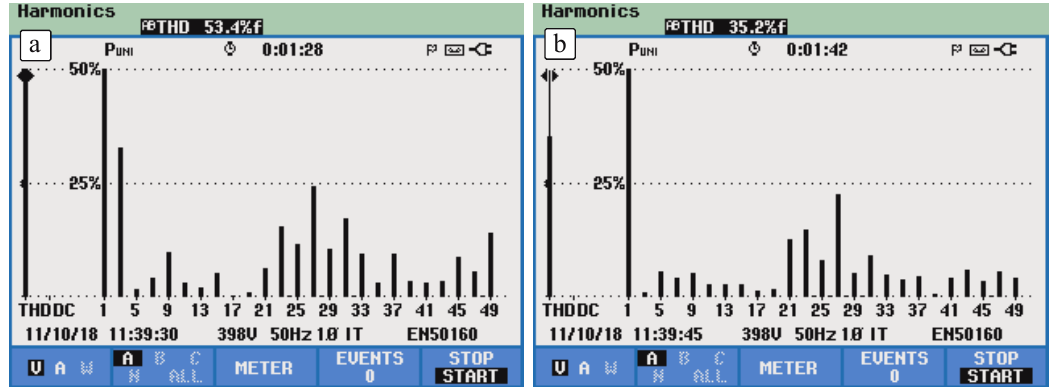
Figure 7. Steady-state single-phase output voltage harmonic spectrum. ( a ) m a = 0.8; ( b ) m a =